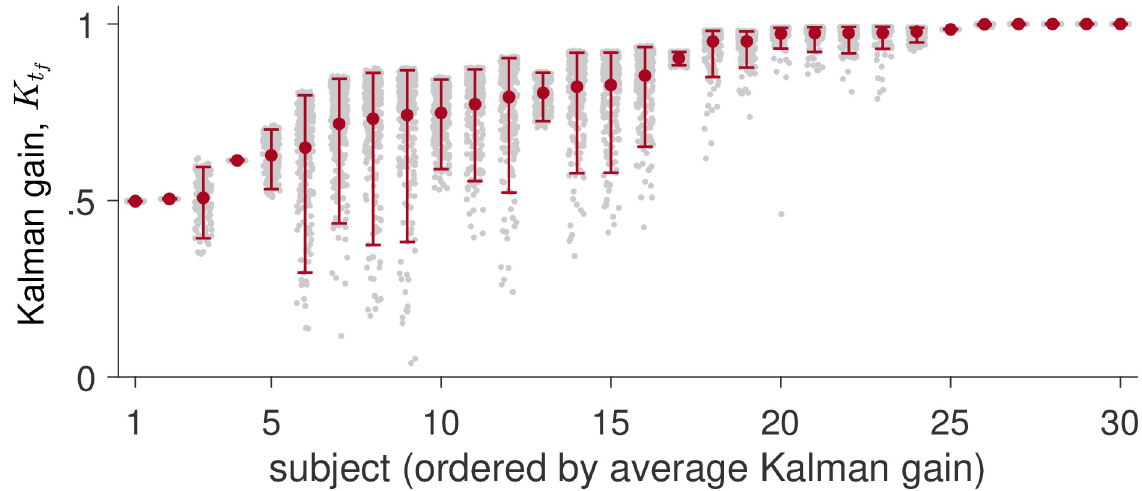
Fig 12. Computed Kalman gain for all participants and all trials. The Kalman gains computed for each trial for each participant are shown as gray dots. The mean Kalman gain and 95% confidence intervals are shown in red.